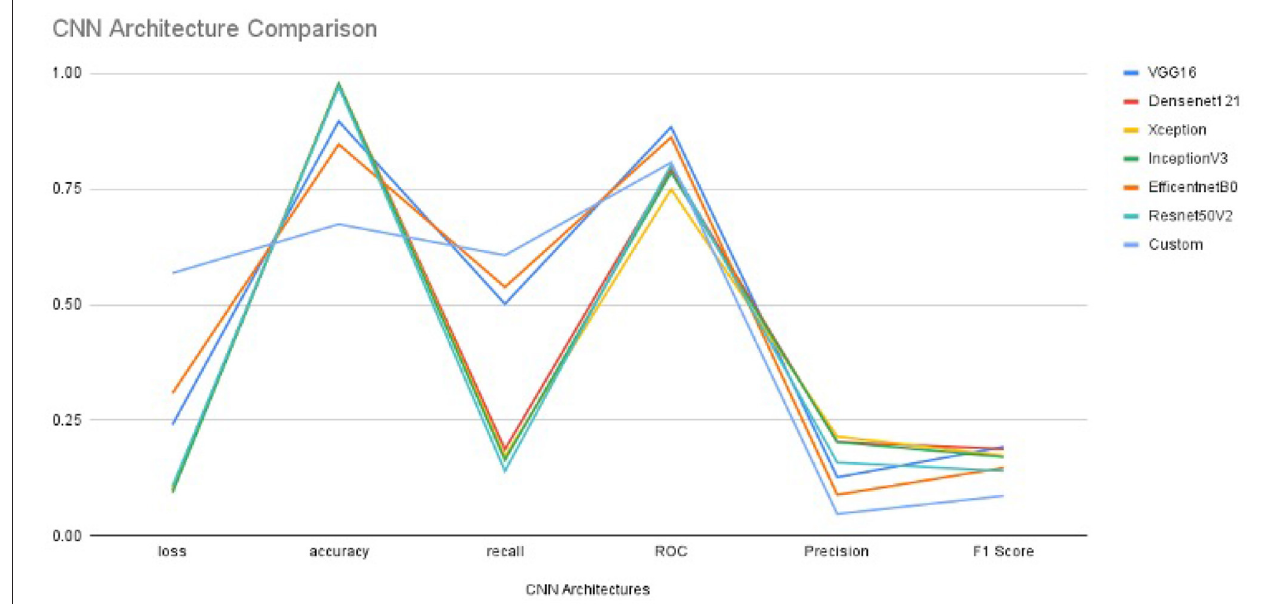
FIGURE 3 | The Performance metrics of CNN architectures with one epoch.